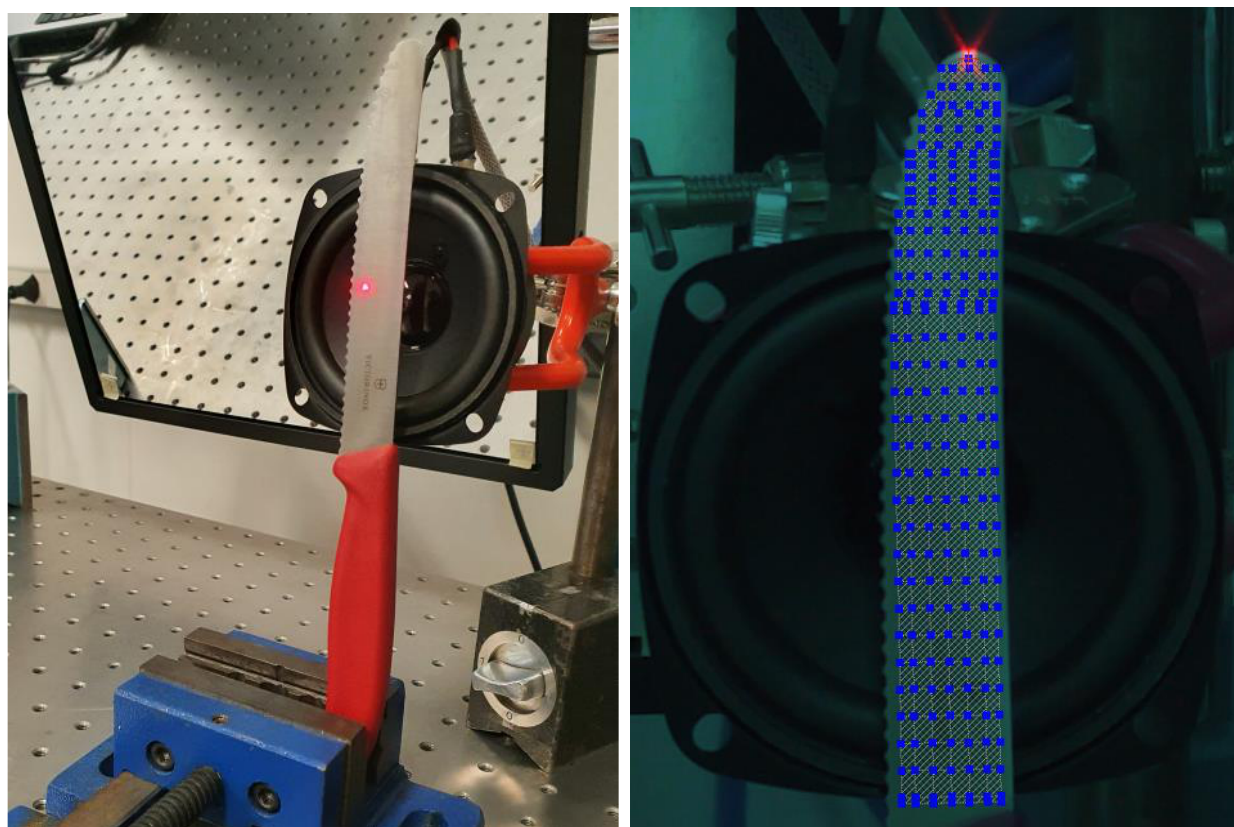
Figure 5. Test object with the exciter (loudspeaker) in a single-point measurement ( left ) and surface measurement — multiple points ( right ). measurement—multiple points ( right